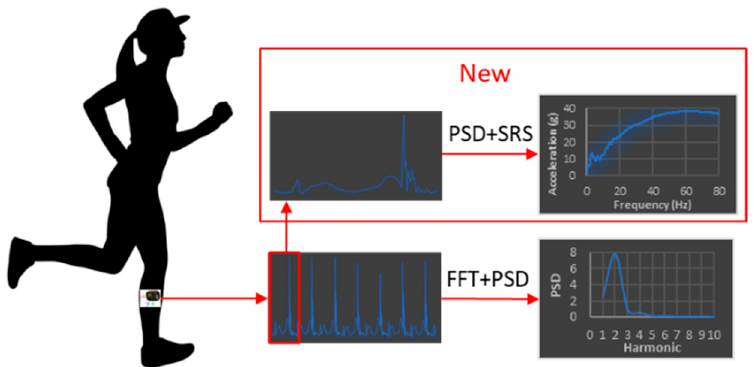
Figure 3. SRS vs. PSD running analysis.